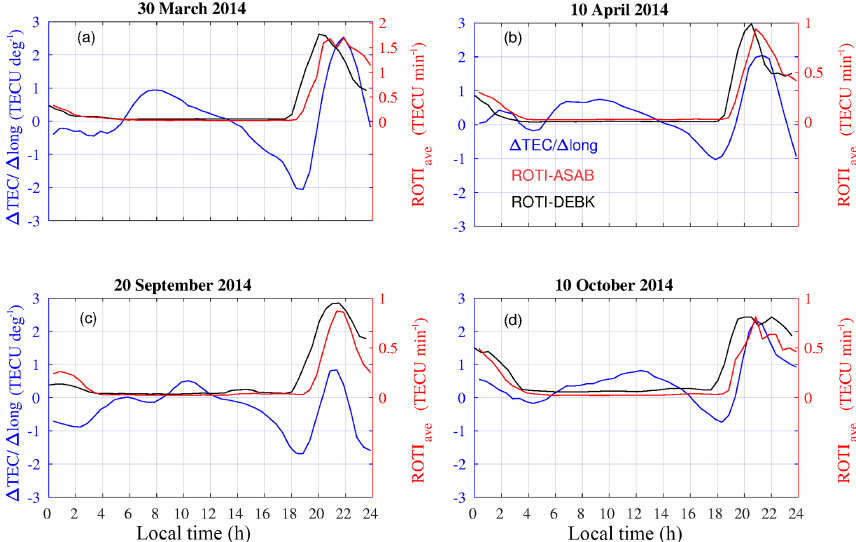
Figure 3. Typical examples of diurnal variation in the spatial gradient of TEC (blue curve) and the ROTI over ASAB (red curve) and DEBK (black curves) on (a) 30 March 2014, (b) 10 April 2014, (c) 20 September 2014 and (d) 10 October 2014.